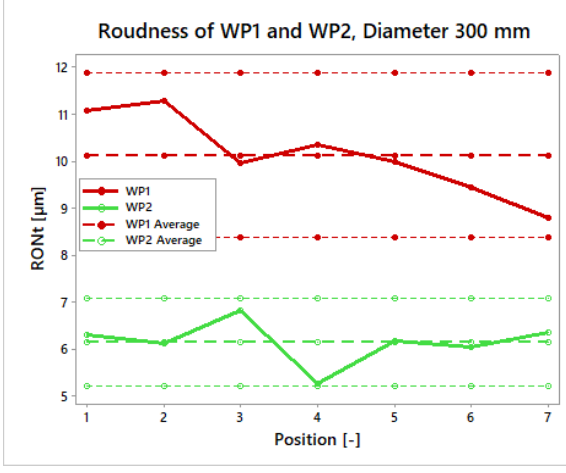
Figure 12. Evaluation of total roundness (RONt), 300 mm diameter.